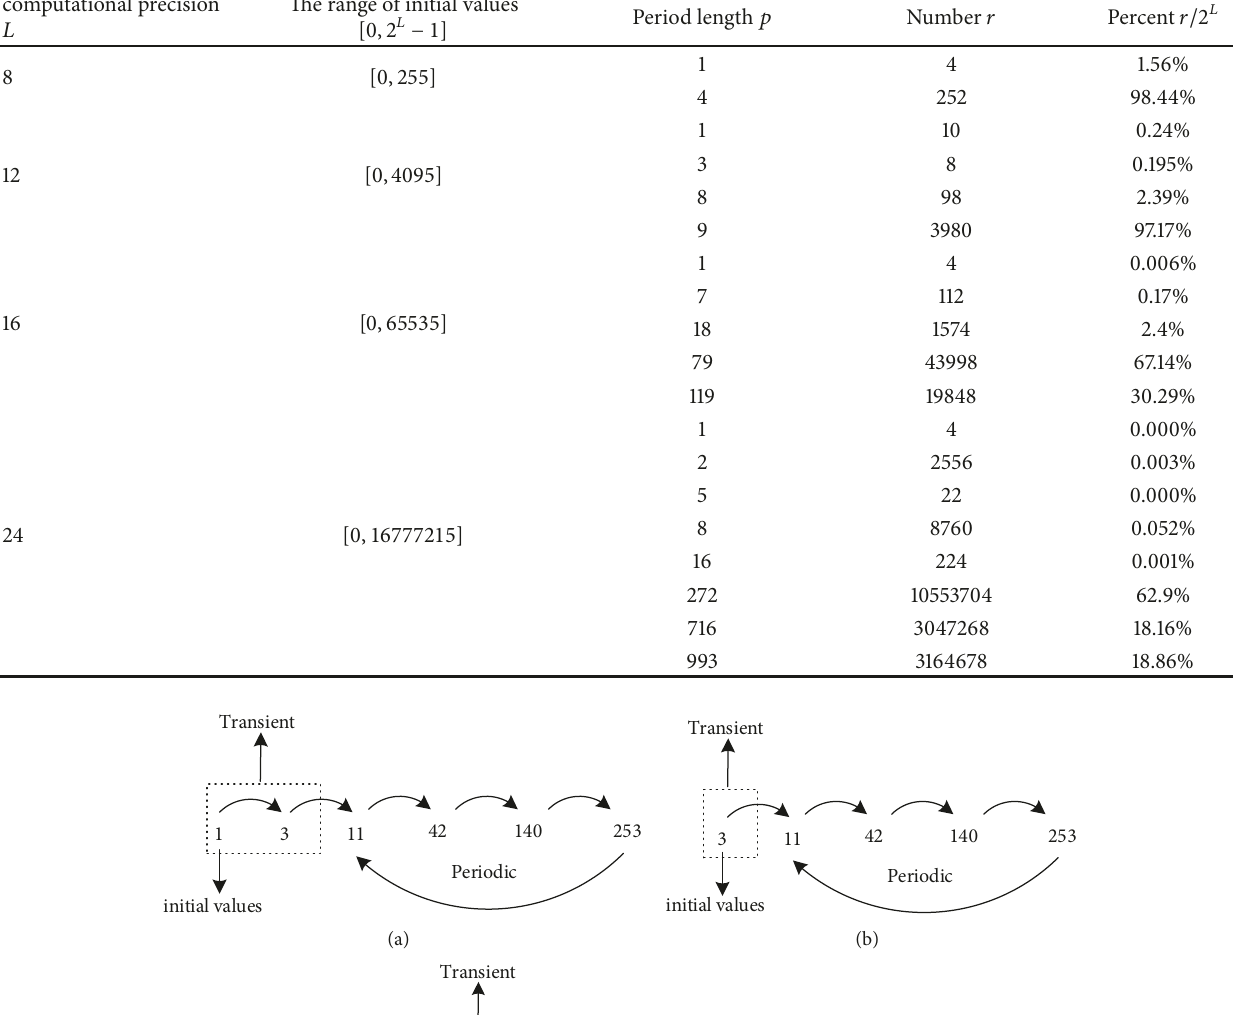
Table 2: The statistical analysis of Logistic sequence periodicity with different computational precision.